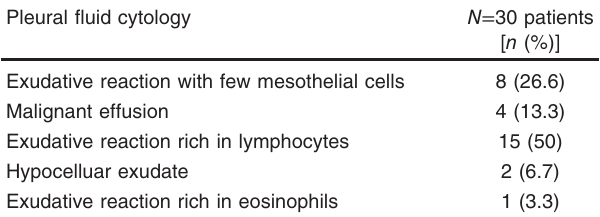
Table 1 Pleural fluid cytology results among studied group Pleural fluid